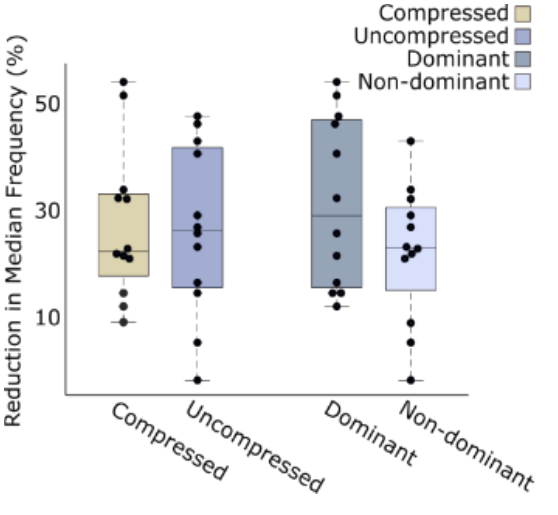
Figure 6: Rates of fatigue for the dominant vs. nondominant arm, and the compressed vs. uncompressed arm. The rate of fatigue is measured as the scalar of the trendline for the median frequency analysis of EMG recordings of each arm. The upper and lower box boundaries represent the respective upper and lower quartiles, the whiskers represent the maximum and minimum excluding outliers, and the centre line represents the